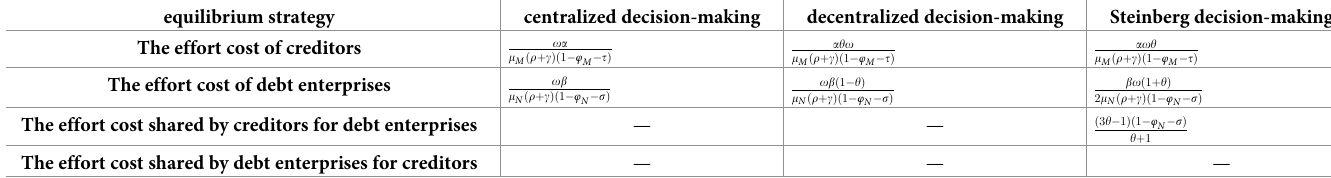
Table 1. Comparison of differential game equilibrium strategies under different decision-making situations. equilibrium strategy centralized decision-making decentralized decision-making Steinberg